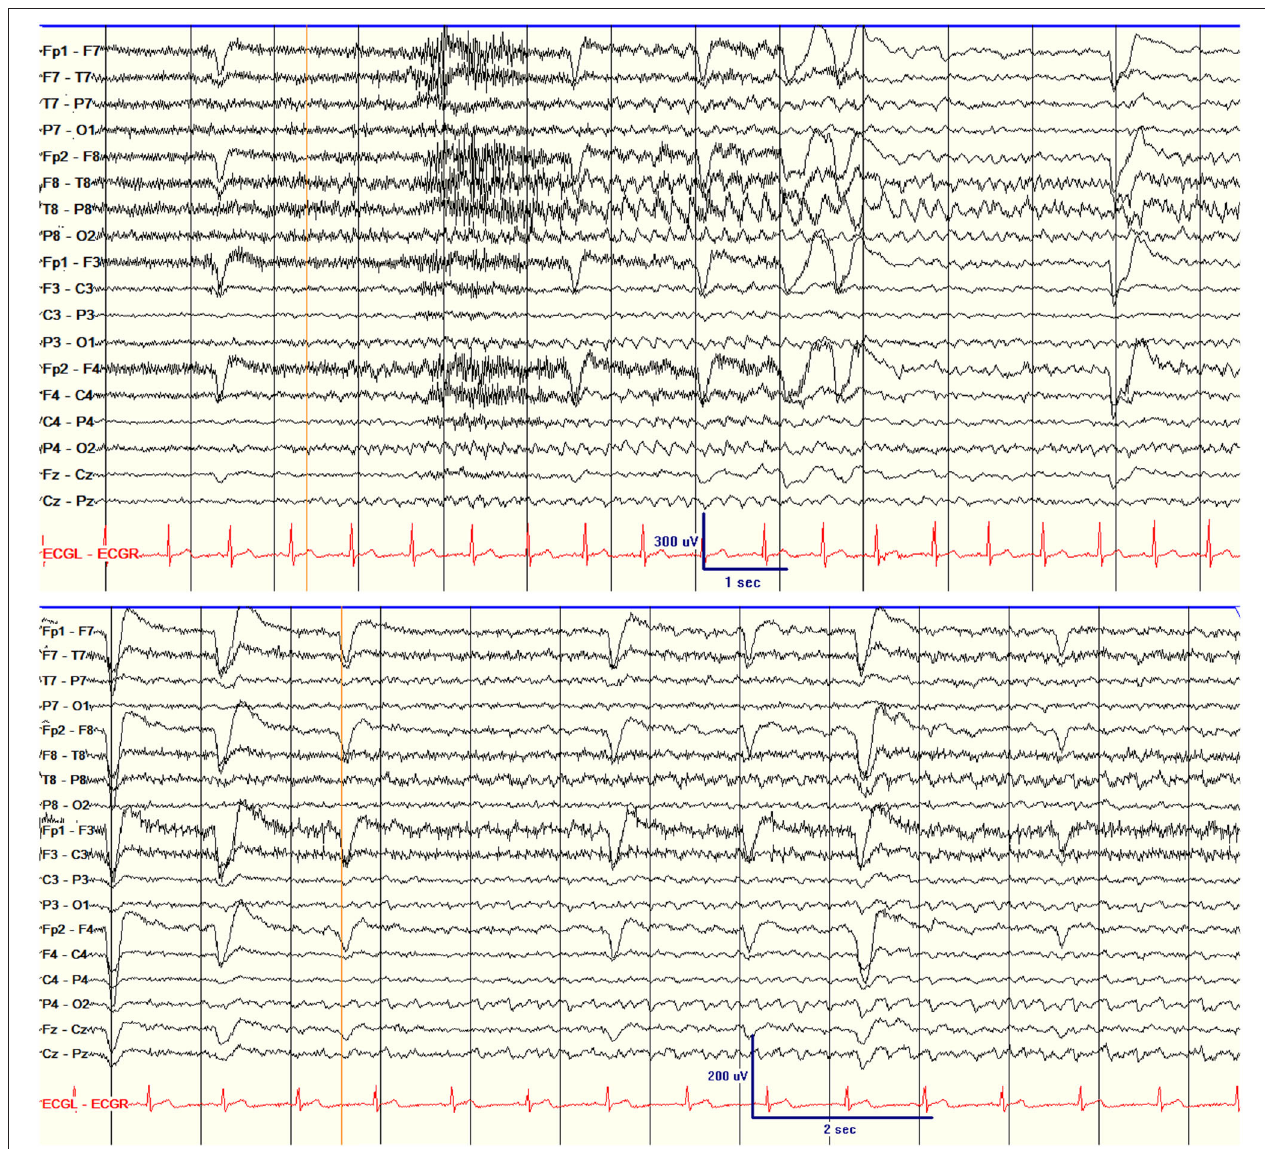
FIGURE 2 | Scalp EEG showing the unilateral seizure onset (right temporal seizure onset) in patient 18 (top) and non-lateralizing seizure onset in patient 1 (bottom). The orange lines indicate EEG seizure onset.